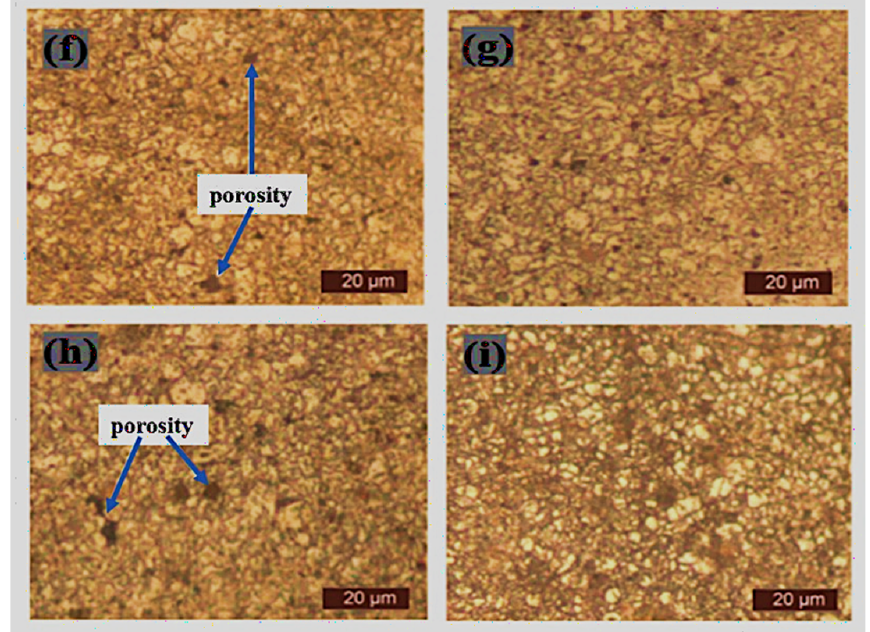
Figure 10. Microstructure of sintered samples ( f ) S6, ( g ) S7, ( h ) S8, and ( i ) S9.